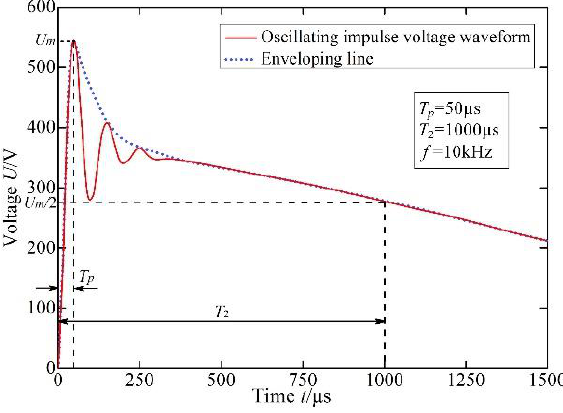
Table 1. Waveform parameters of SI voltage and their corresponding circuit parameters.